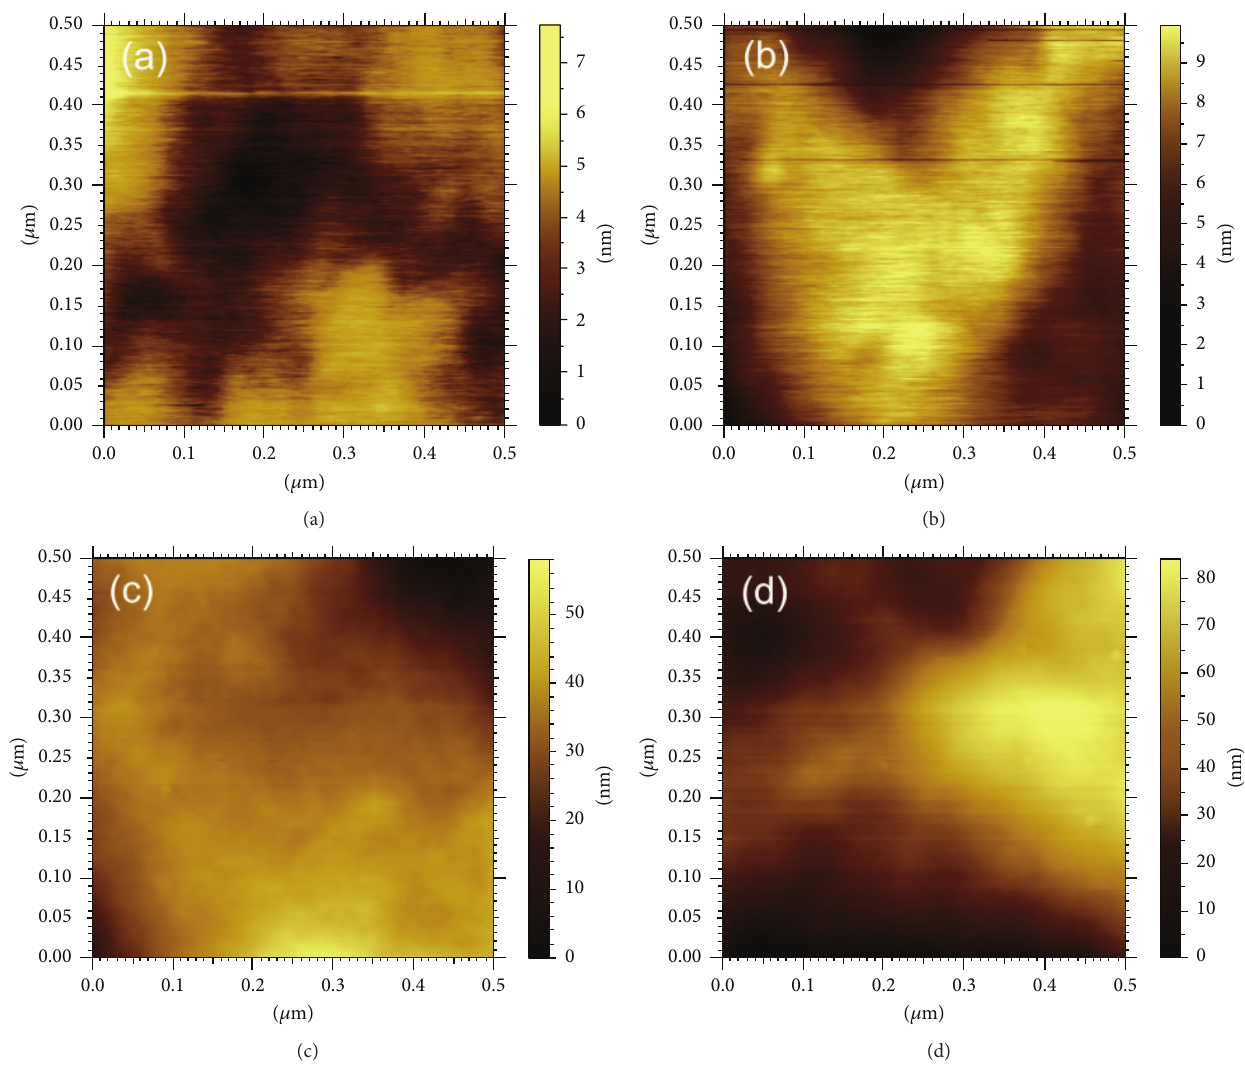
Figure 4: AFM images of PEDOT:PSS films sprayed with different deposition temperatures: (a) 70 ∘ C, (b) 100 ∘ C, (c) 130 ∘ C, and (d) 160 ∘ C. The PEDOT:PSS films were deposited with IPA-diluted solution ((PEDOT:PSS): IPA = 1: 14) and 1% Zonyl FS-300 fluorosurfactant.